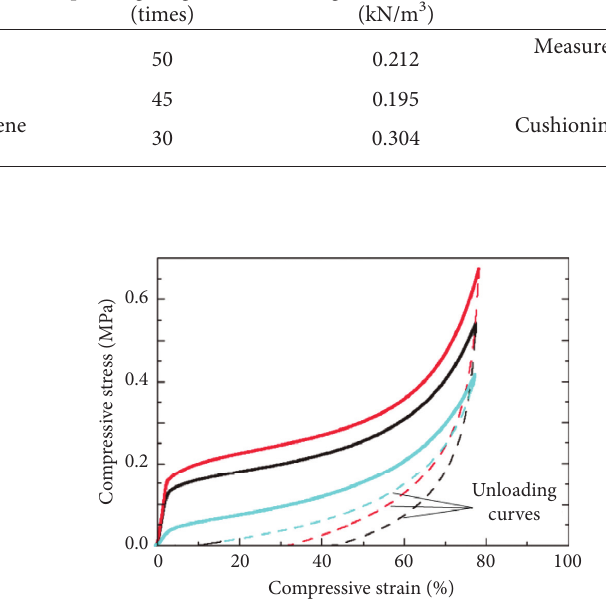
Figure 2: Results of compressive strength tests for each expanded material.